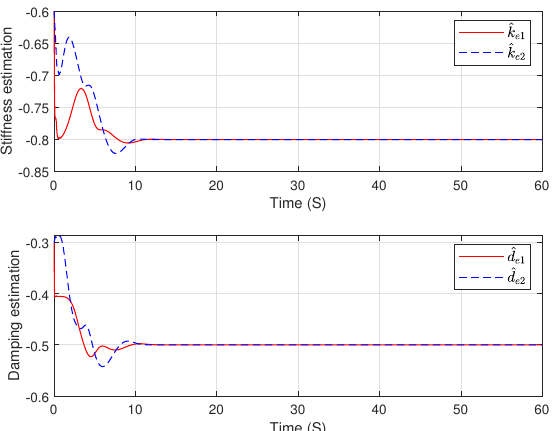
Figure 3. The estimation performance for the environmental stiffness and damping.